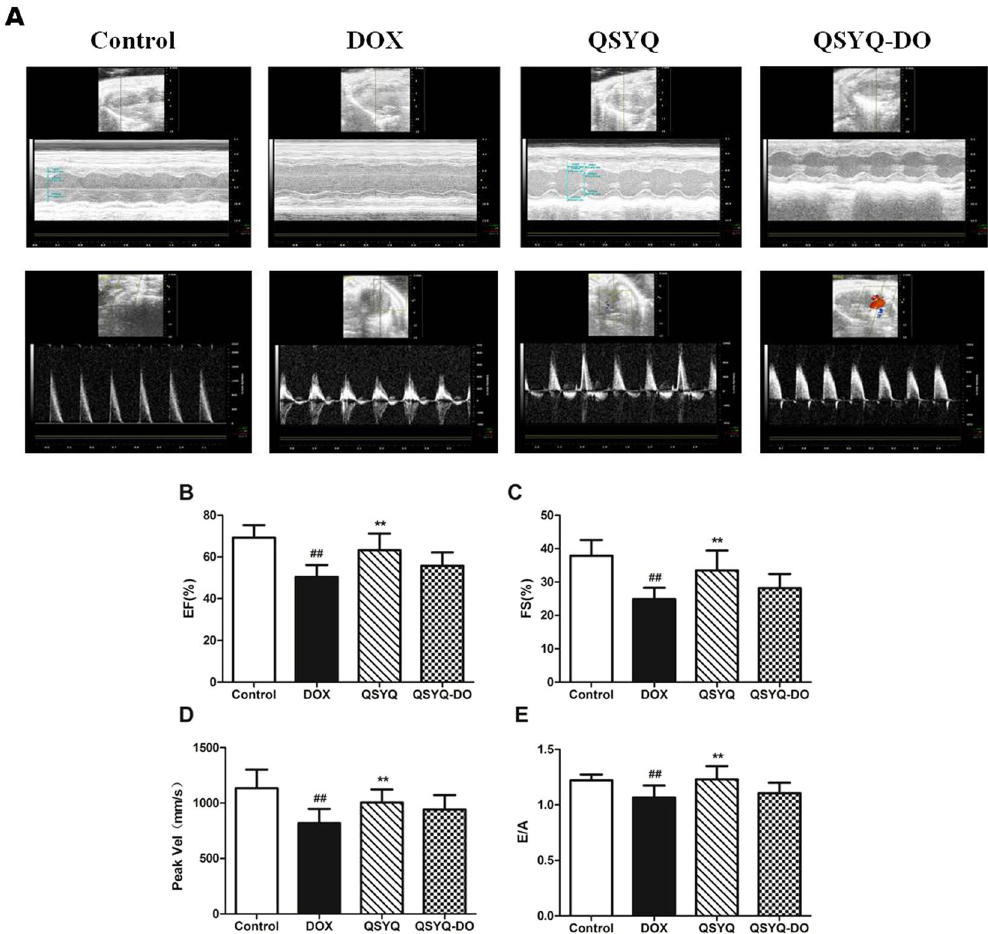
Figure 5. Effects of QSYQ and QSYQ-DO on mouse cardiac function. Left ventricular function measurements were assessed on echocardiography at the end of DOX injection. (A) Representative picture for M-mode, (B) Ejection fraction (EF%), (C) Fractional shortening (FS%), (D) Aortic valve peak velocity, and (E) Maximal early and late transmitral velocities (E/A). Data are expressed as mean ± SD, n = 8. ## p < 0.01 vs . Control group. ** p < 0.01 vs . DOX